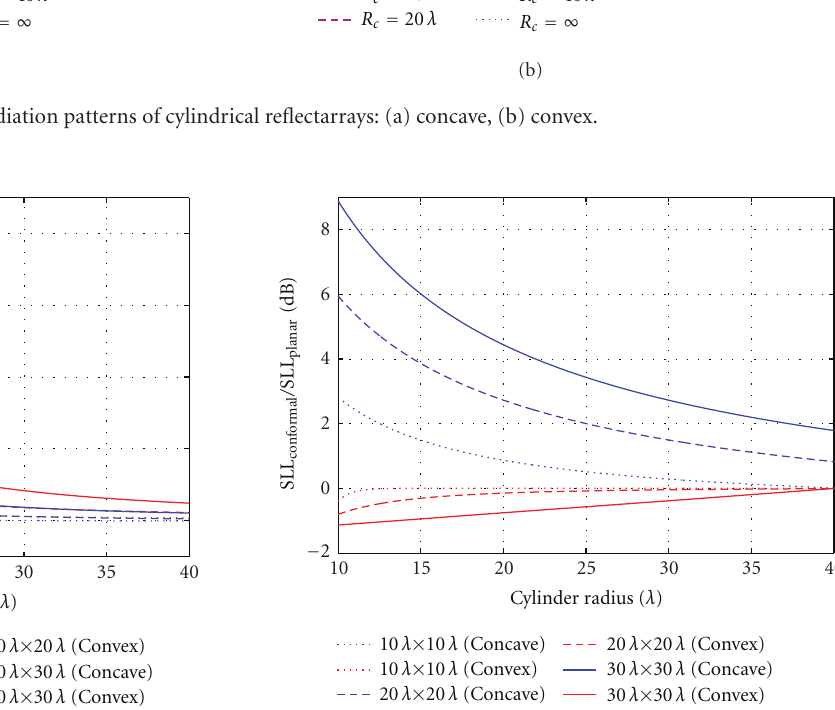
Figure 4: Normalized HPBW in the curvature plane as a function of cylinder radius.